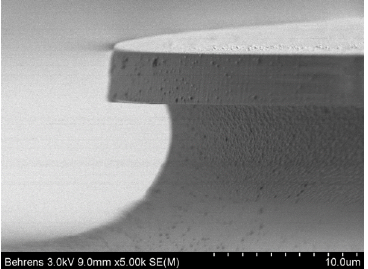
Figure 2: SEM image of a microdisk resonator